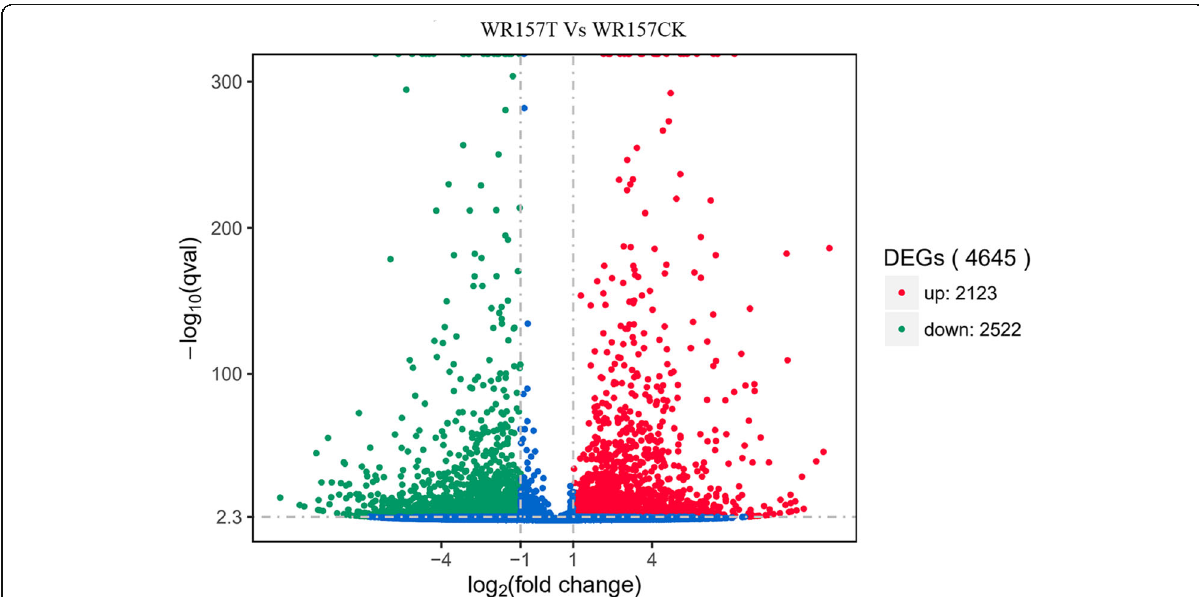
Fig. 4 Upregulated (red) and downregulated (green) genes between WR157T and WR157CK. A total of 4645 differentially expressed genes (DEGs) were found between WR157T and WR157CK; 2123 DEGs were upregulated, and 2522 DEGs were